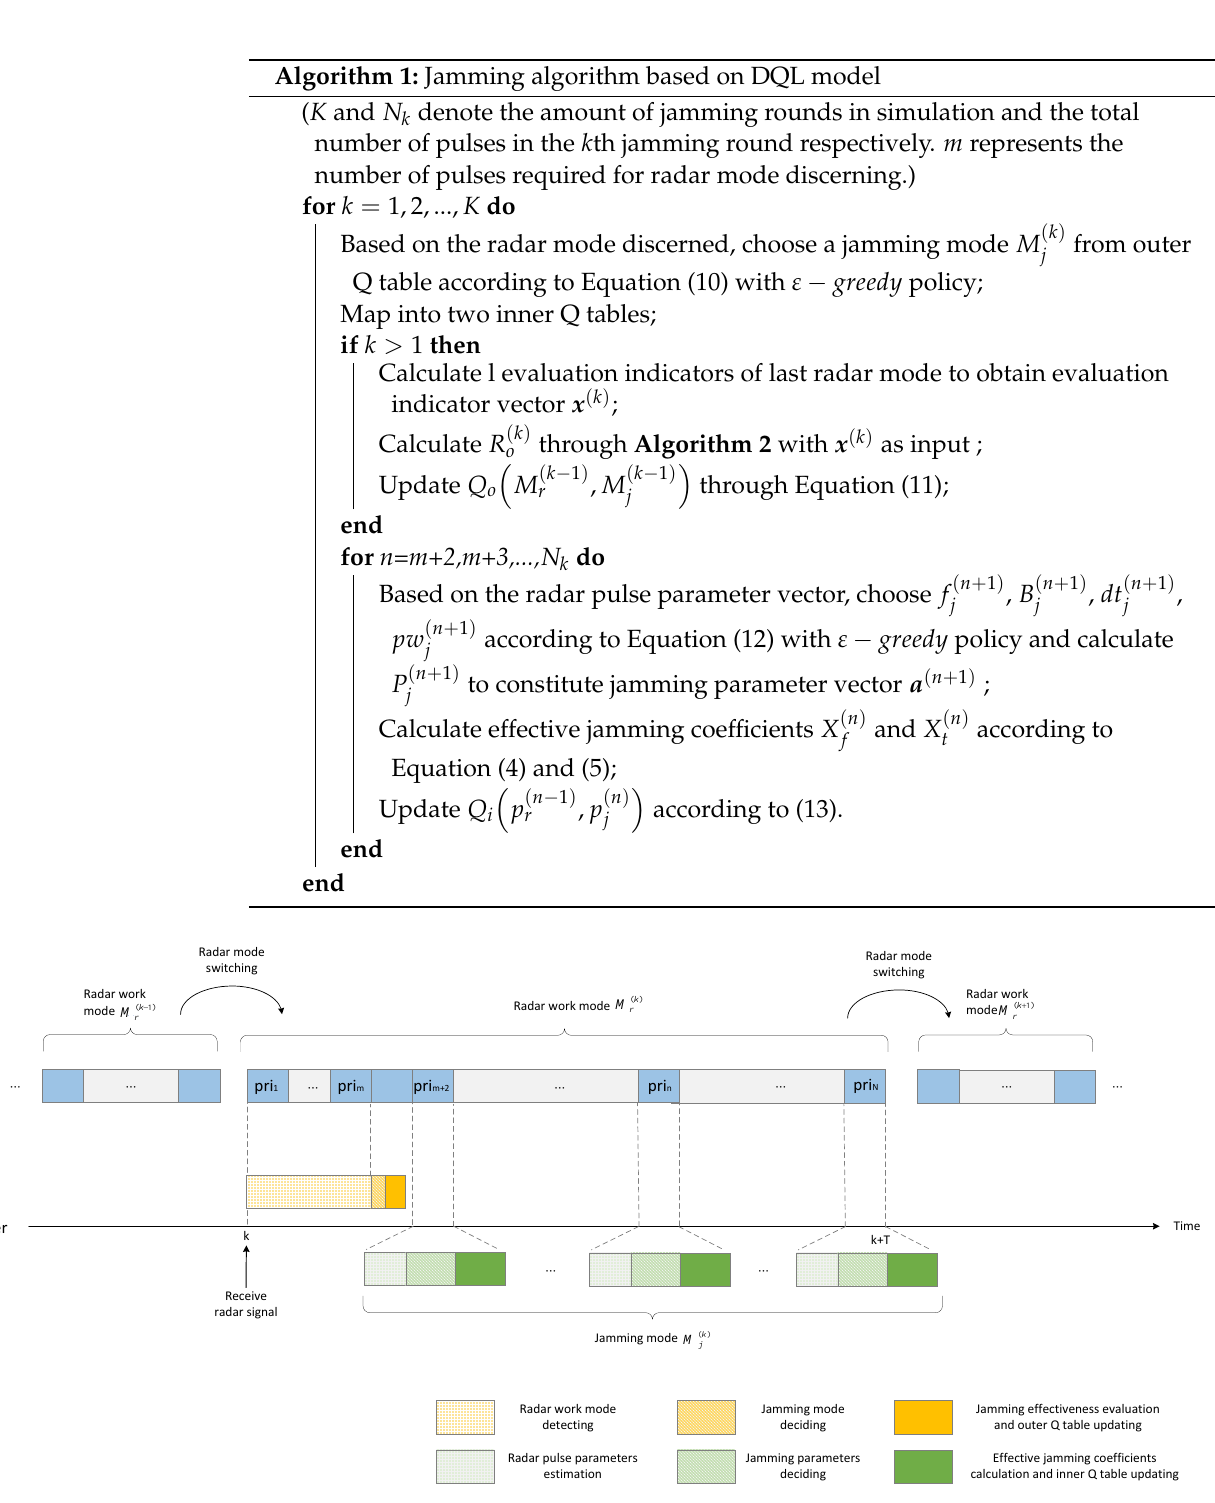
Figure 3. Process of learning and jamming decision making with DQL